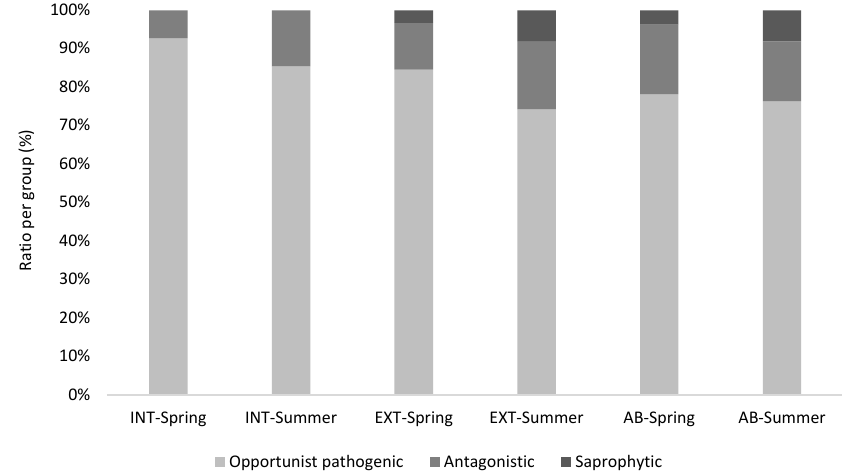
Figure 4. Ratio per group of behavior (%) based on the data used for Table 2. INT: Intensively cultivated; EXT: extensively cultivated; AB: abandoned, in two seasons of 2015, spring and summer.